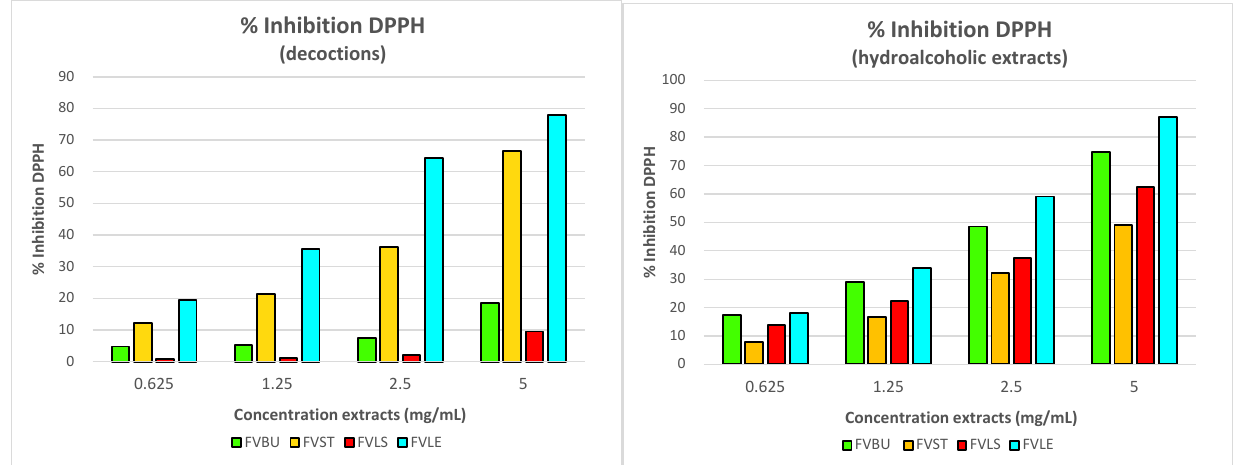
Figure 5. Percentage of inhibition of the radical DPPH of F. vulgare . The concentrations of the tested extracts are 0.625, 1.25, 2.5 and 5 mg/mL. The percent of inhibition of DPPH is the average of three experiments and the standard deviation values range from 0.01 to 0.05.